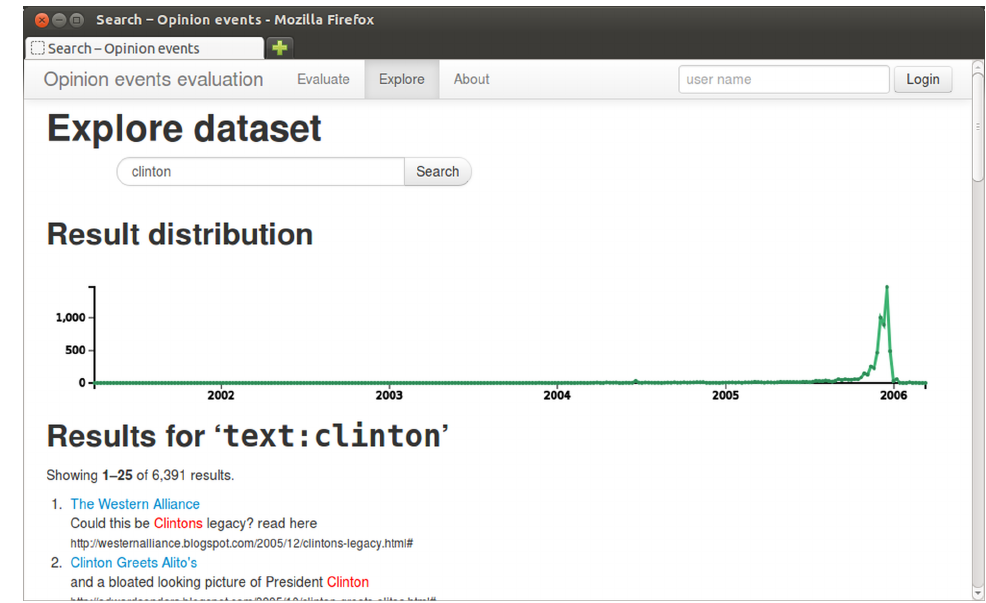
Figure 7. Keyword search in the exploration tool. The graph shows the distribution of result documents over